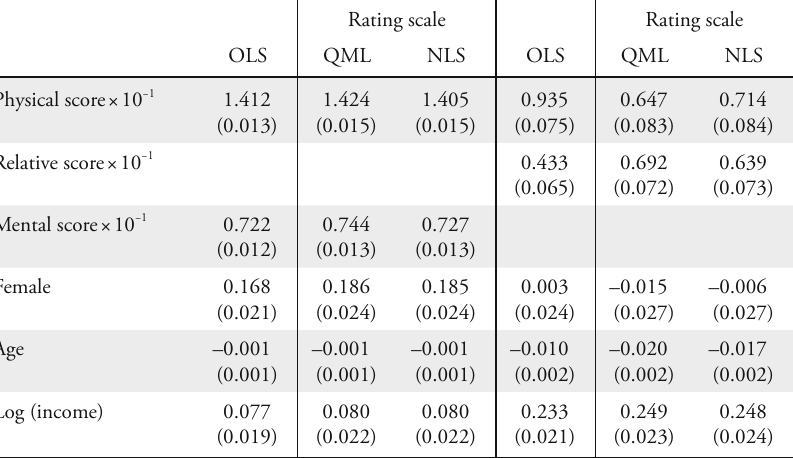
Table 1: Determinants of Health Satisfaction ( N (cid:3)